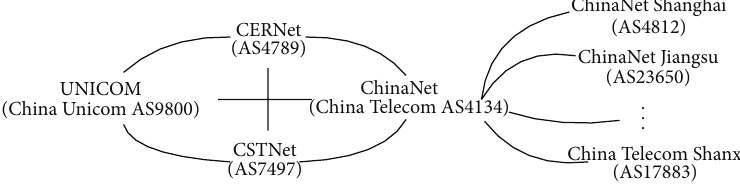
Figure 2: Connection of some large networks in the Chinese Internet.